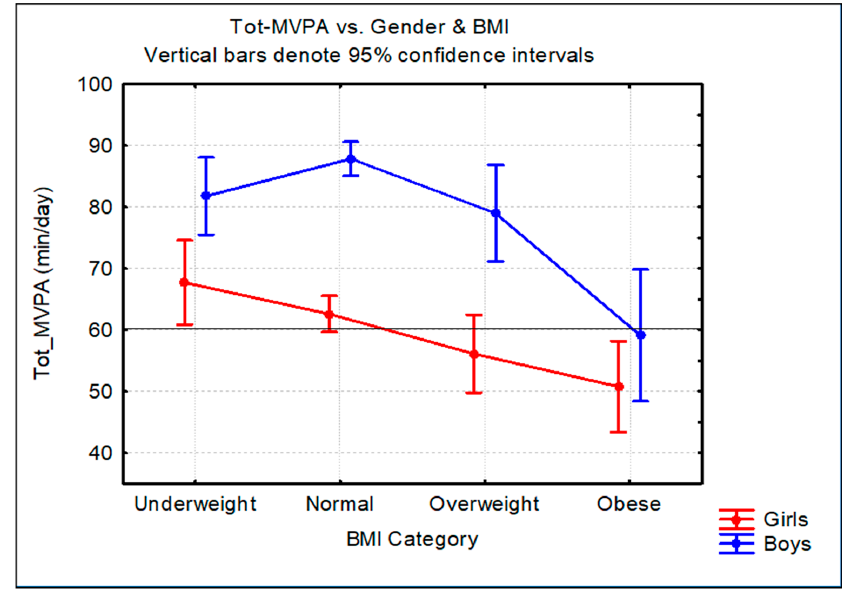
Figure 2. Mean total MVPA (min/day) stratified by sex and BMI categories.